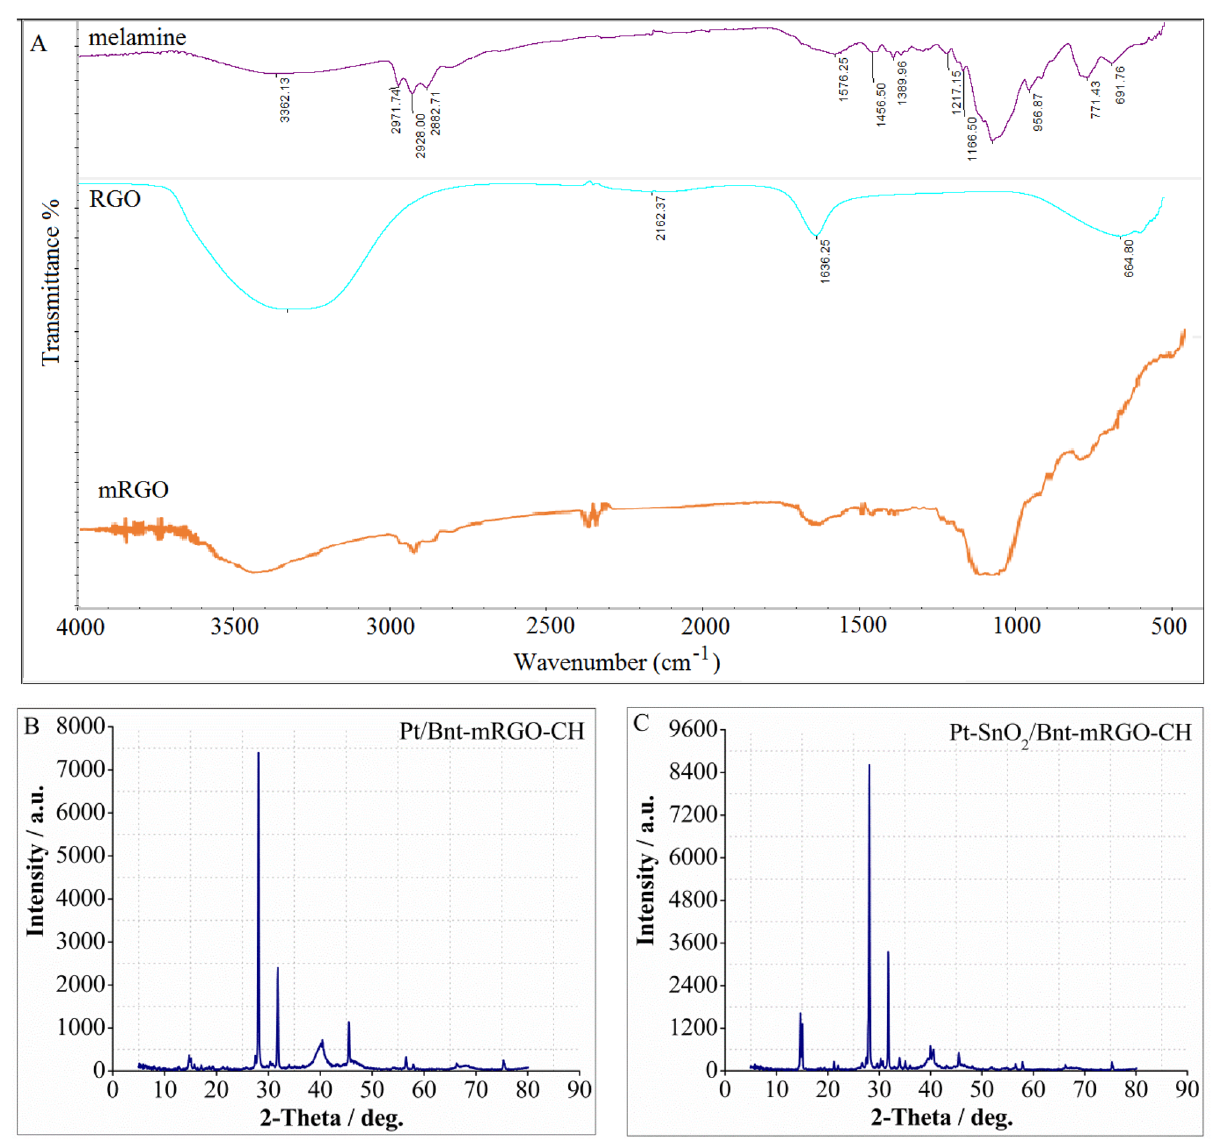
Figure 1. ( A ) FTIR spectra of melamine, RGO and mRGO. ( B ) XRD pattern of Pt/Bnt-mRGO-CH and ( C ) XRD pattern of Pt-SnO 2 /Bnt-mRGO-CH